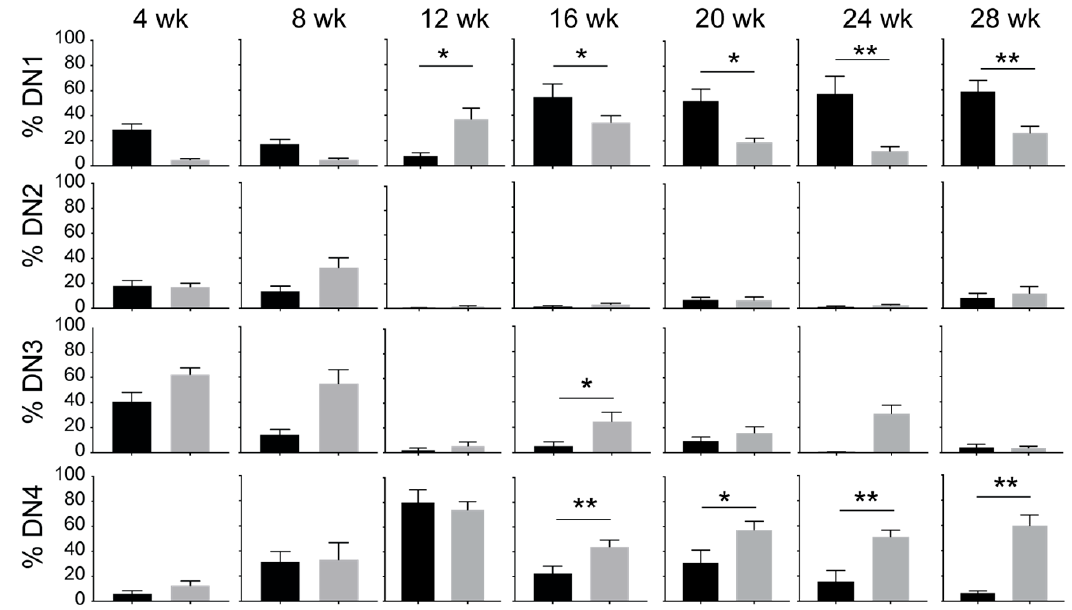
Figure 3. IL-15 deficiency in NOD. Scid mice yields the progression of DN thymocytes to the DN4 stage. Proportion of DN1 (CD44+CD25-), DN2 (CD44+CD25+), DN3 (CD44-CD25+) and DN4 (CD44- CD25-) subsets defined by CD25 and CD44 expression in NOD. Scid (black bars) and NOD. Scid.Il15 − / − (gray bars) mice. n = 4–8 mice per group. Mean and standard deviation (SD) are shown. Statistical significance was calculated using Mann–Whitney’s test. * p > 0.05; ** p > 0.01.